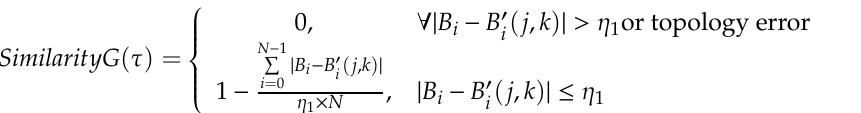
( b ) Figure 7. Topological conflict: ( a ) vertex elimination and ( b ) maintenance of spatial directional relationship. 3. Extraction of Topographical Features on a Road Section 3.1. Extraction of 3D Terrain Feature